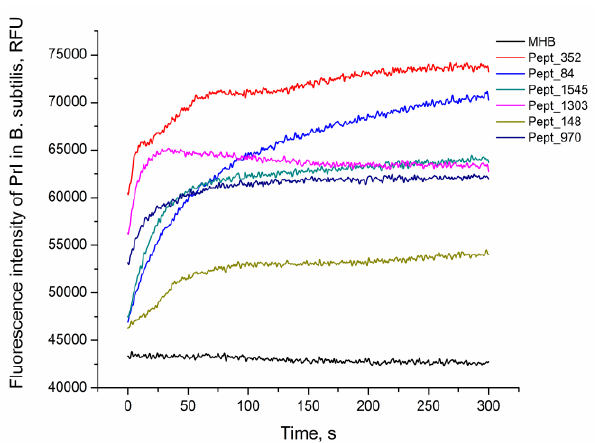
Figure 2. AMP activity against B. subtilis . Kinetics of propidium iodide (PI) penetration after the addition of AMPs to B. subtilis at a concentration equal to 2 × MIC. The negative control corresponds to the bacteria incubated with PI without peptide (MHB).